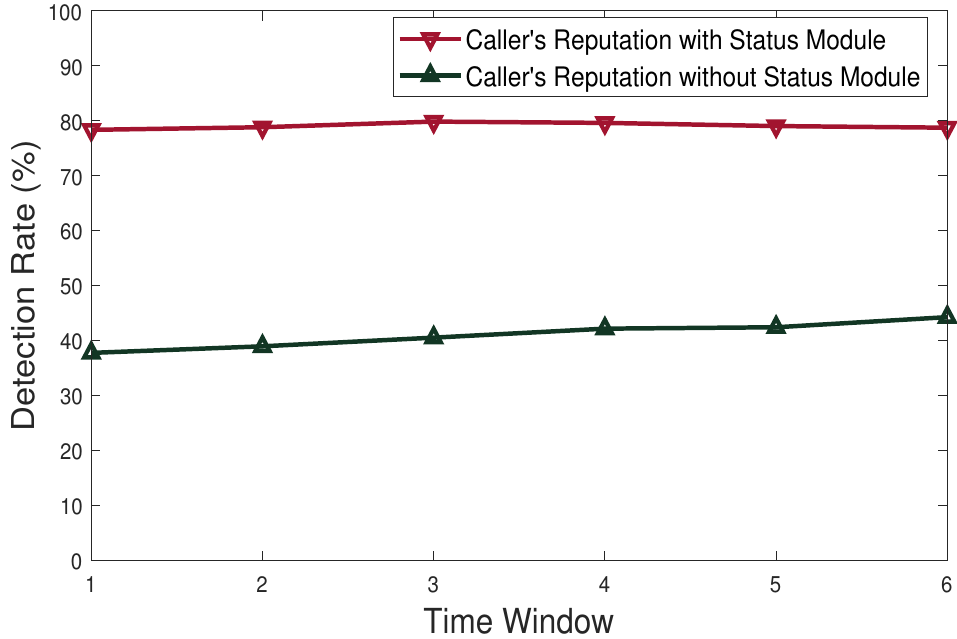
Figure 10. Efficiency against